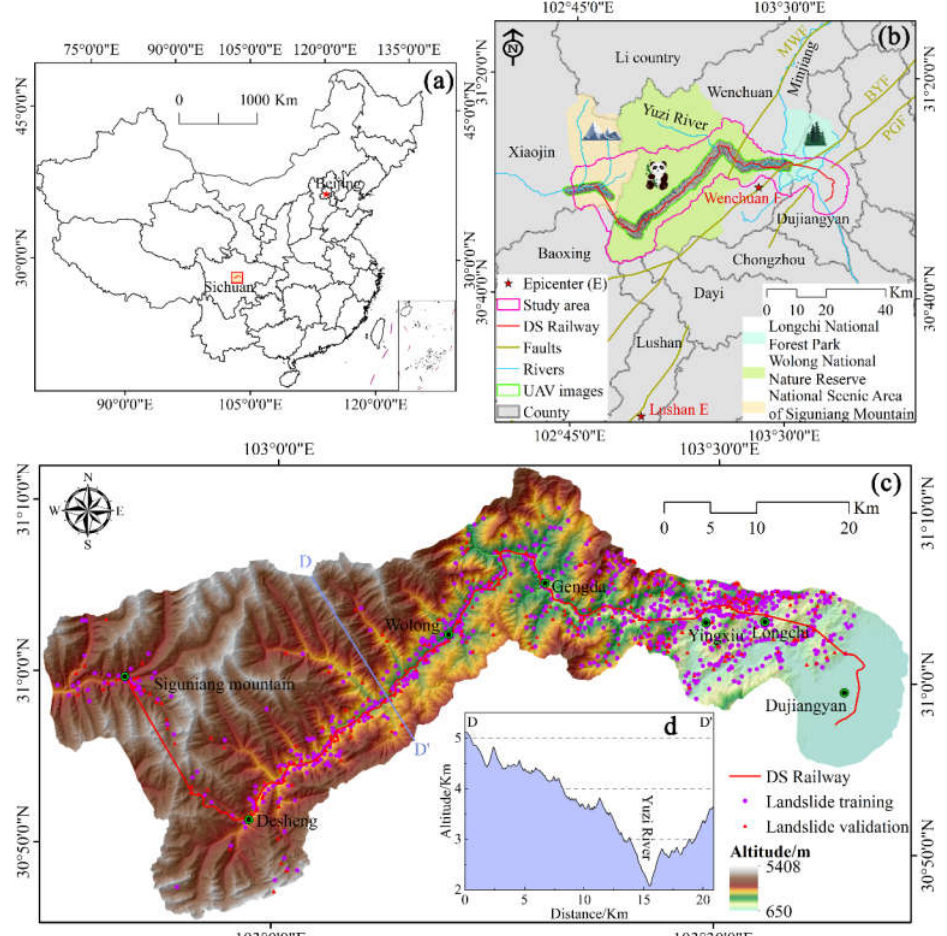
Figure 1. Location of the study area. ( a ) General map of China; ( b ) Location of the study area; ( c ) Landslide inventory map; ( d ) Topographic cross-section of D–D’ with different reliefs of approximately 3040 m. PGF: Pengxian-Guanxian faults, BYF: Beichuan-Yingxiu faults, MWF: Maoxian-Wenchuan faults.